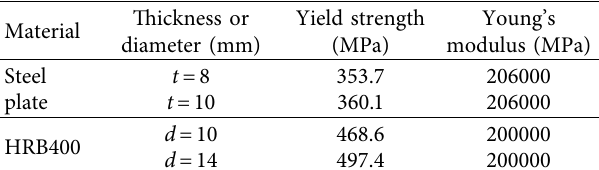
Table 3: Material properties of steel and